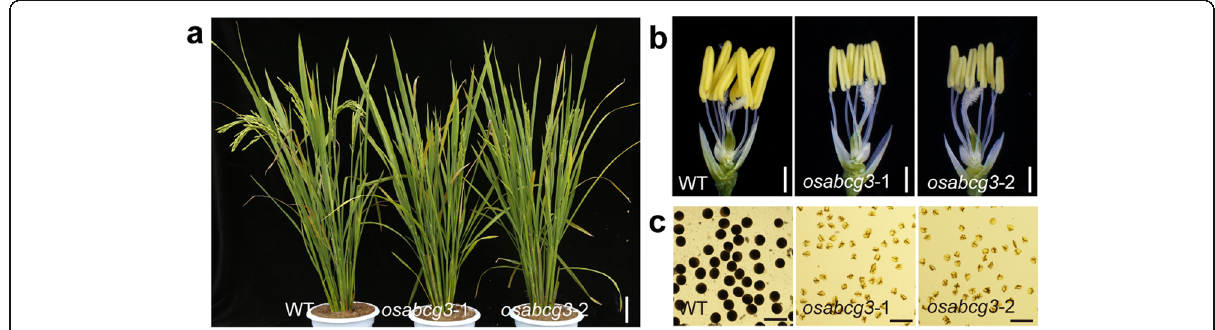
Fig. 1 Phenotype of osabcg3 – 1 and osabcg3 – 2. a Plants of wild-type (WT), osabcg3 – 1 and osabcg3 – 2 after heading. b Spikelets of WT, osabcg3 – 1 and osabcg3 – 2 with the palea and lemma removed. c Pollen grains of WT, osabcg3 – 1 and osabcg3 – 2 with I 2 -KI staining. Scale bars = 10 cm ( a ); 1 mm ( b );100 μ m ( c